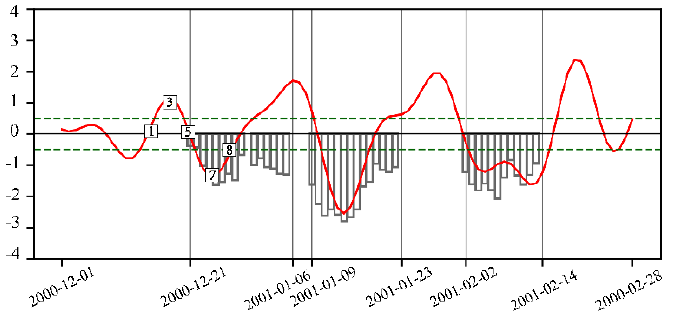
Figure 3. Time series of T min minus threshold (grey bar, unit: °C) and standardized 10–30 d filtered T min (red line) averaged over the NE-N during the winter in 2000 (green dashed line represents 0.5 standard deviation; between the two vertical lines is an ECE; the numbers, 1, 3, 5, 7, and 8, represent the different phases of the ISO).